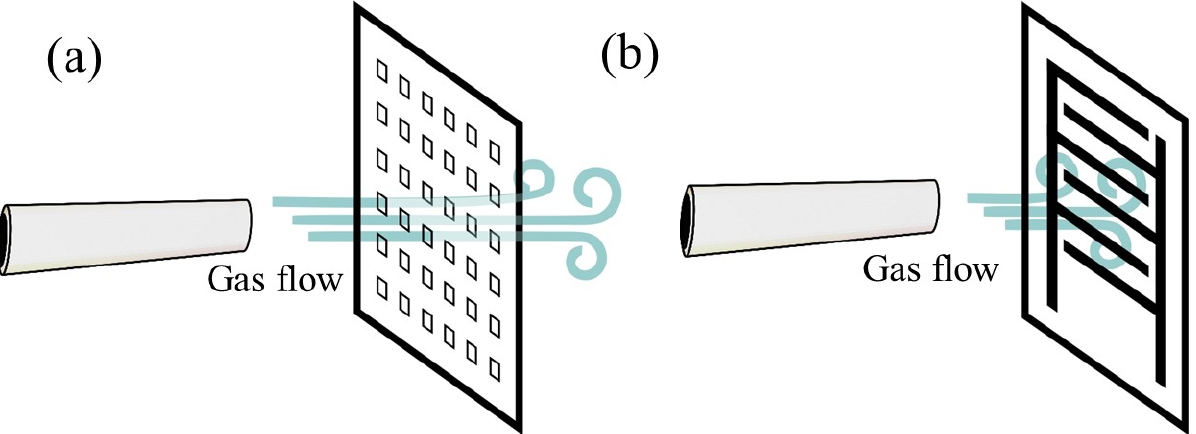
Figure 1. ( a ) With and ( b ) without a TSV-structured gas sensor.